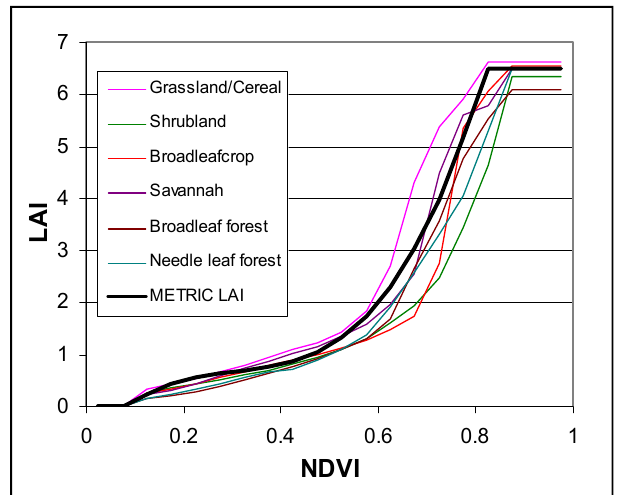
Figure 2. At-surface NDVI vs. LAI for six surfaces (MODIS backup method), and generalized curve (METRIC